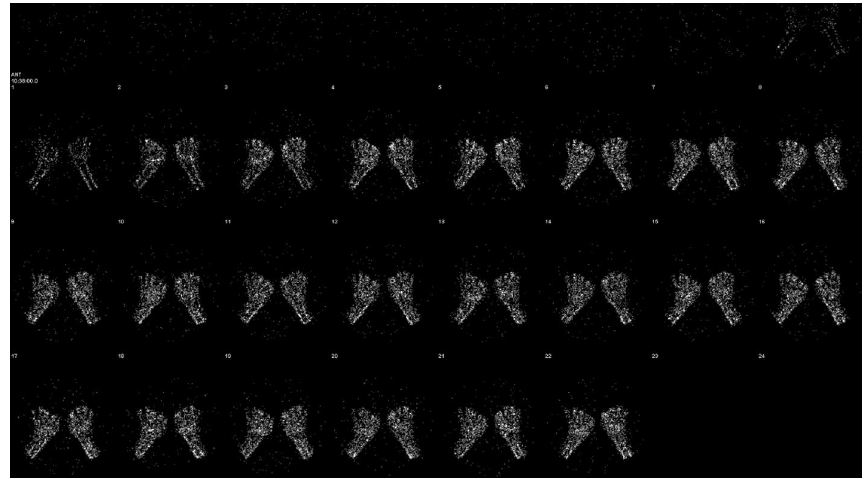
Fig. 2 Dynamic multiphase 99mTc-MDP bone scintigraphic. Images of the hands show absent tracer uptake throughout the bilateral phalanges in the palmar blood flow phase immediately after the radiotracer